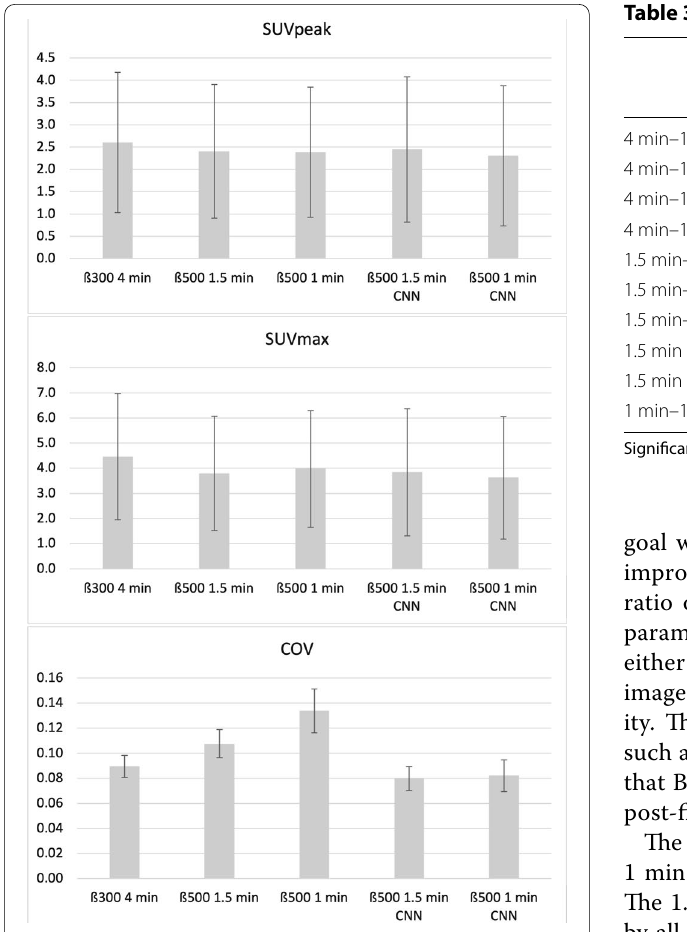
Fig. 5 Comparisons of mean SUV peak , SUV max and COV with error bars showing standard deviations for all image sets. SUV peak mean values for both 1.5 min and 1.5 min CNN were 2.4. SUV max mean values for both 1.5 min and 1.5 min CNN were 3.8. COV for 1.5 min CNN was less than the 1.5 min image set, indicating less noise